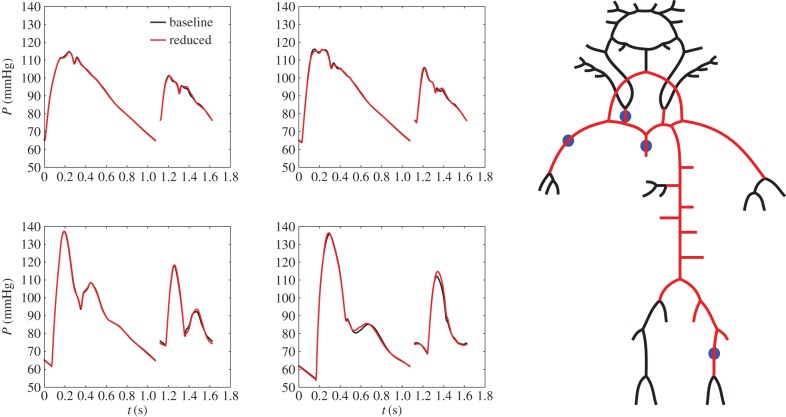
Optimal reduced network for ascending aorta (top left), right common carotid artery (top middle), right brachial artery (bottom left) and left femoral artery (middle bottom). The network is the same as shown in figure 13; however, results are shown for two different inlet waveforms as described in §2.6.